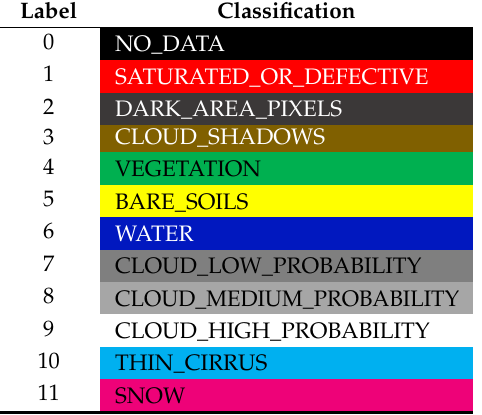
Table 2. General-purpose, user- and application-independent ESA Level 2 SCM legend proposed in [13–15], consistent with the standard 3-level 8-class Food and Agriculture Organization